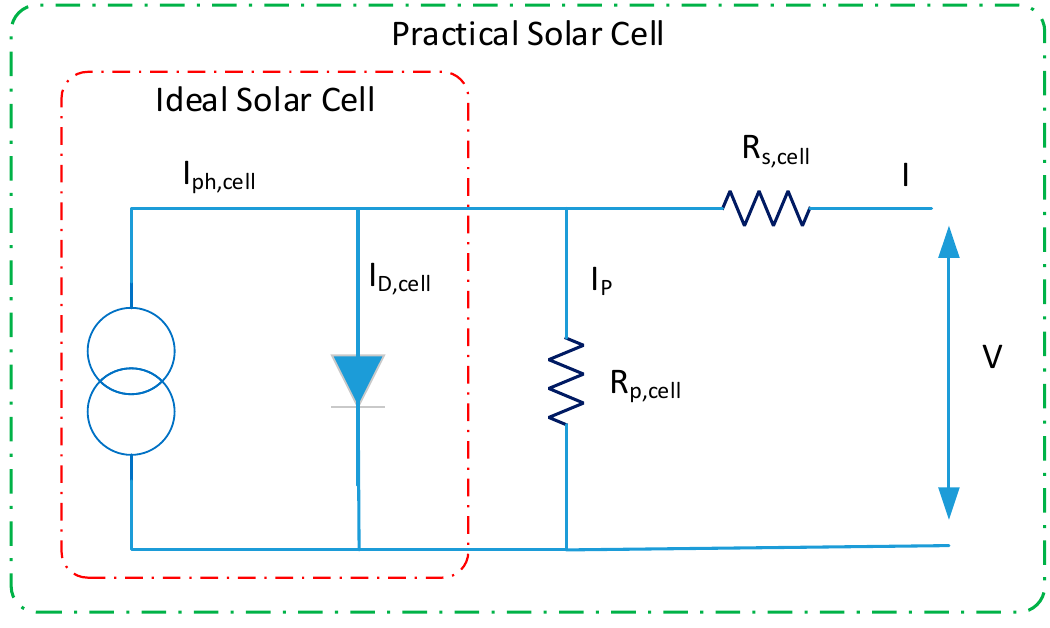
Figure 4. The PV cell’s equivalent circuit [35].